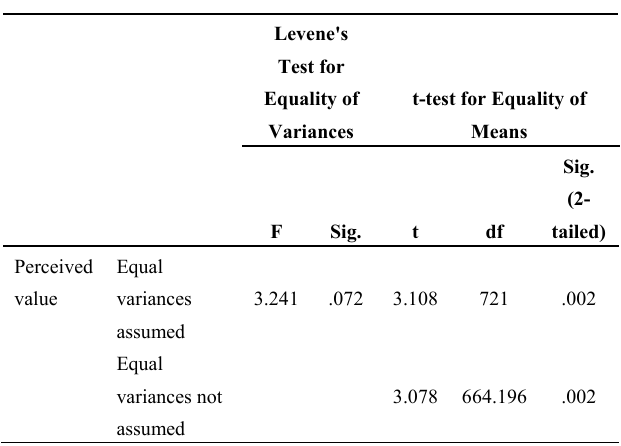
Table 14: The Independent Samples Test for the difference between the fuzzy semantics of the perceived value of consumers with different genders by the features of furniture product design